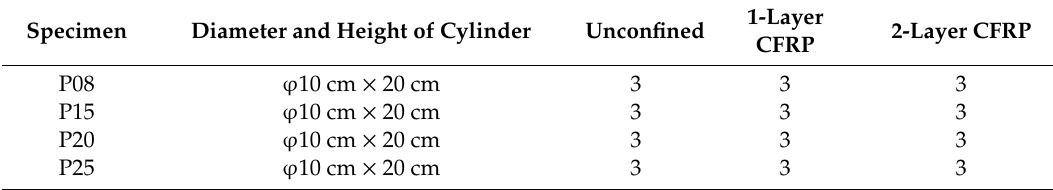
Table 5. The design parameters and specimen notation of 36 concrete